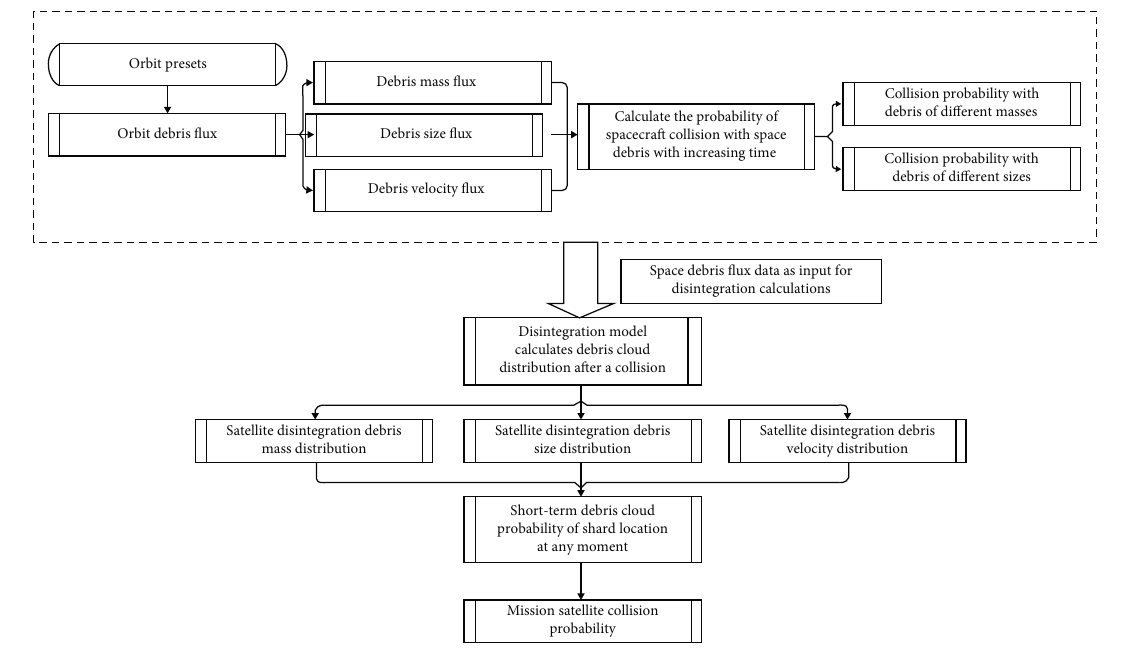
Figure 2: Computational model fl ow chart.